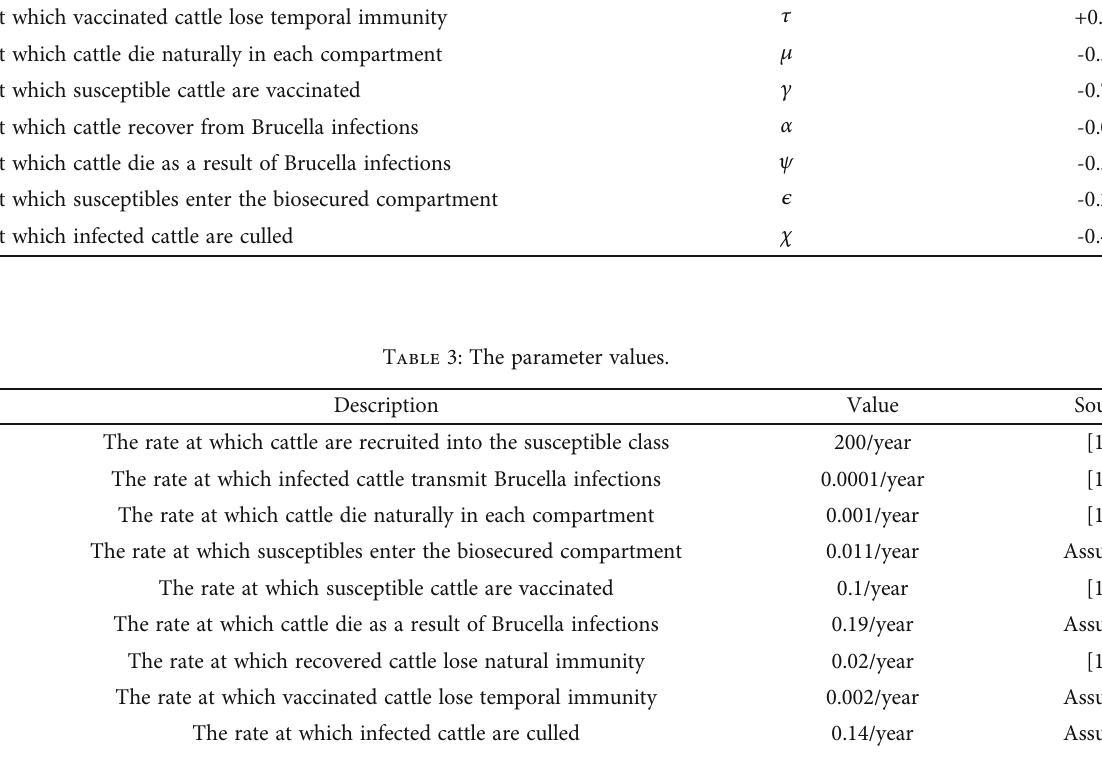
Table 2: Sensitivity indices of R